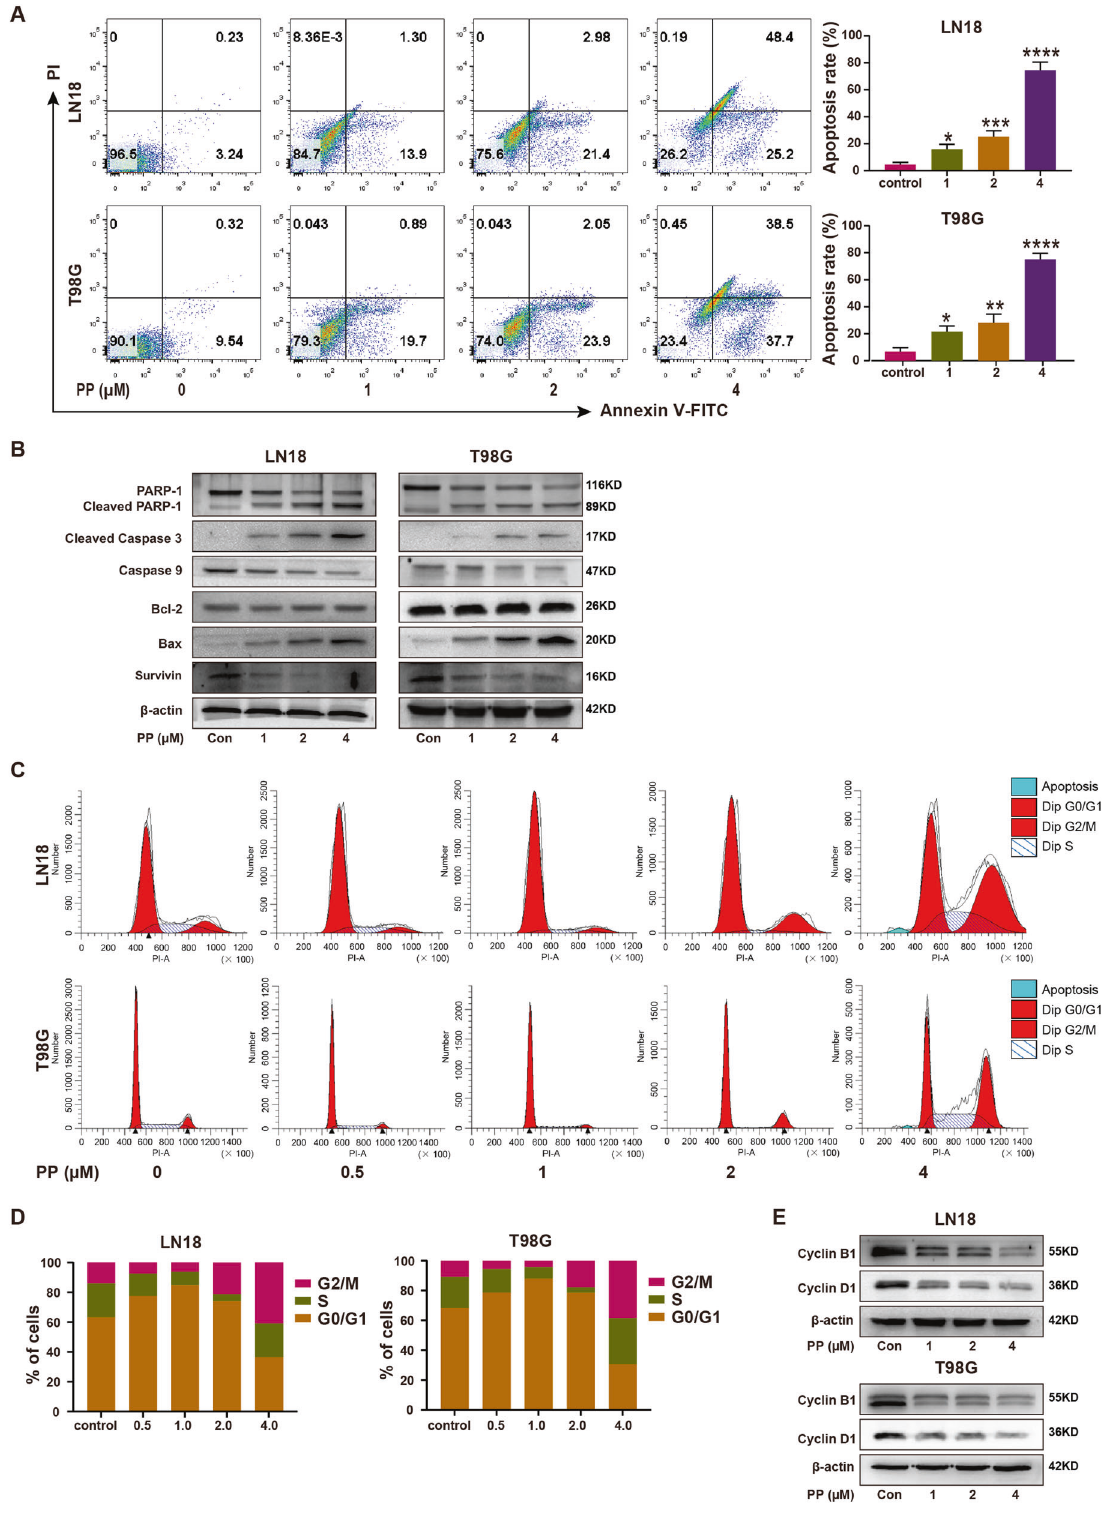
Fig. 2 PP induced GBM cells apoptosis and the arrest of cell cycle. A LN18 and T98G cells were subjected to PP treatment at various concentrations for 48 h, and then fl ow cytometry was carried out along with annexin V-FITC and PI staining (left panel). The elevated apoptotic cells were quanti fi ed and presented in the histogram (right panel) ( n = 3). B The protein levels of PARP-1, Bcl-2, Bax, caspase-9, cleaved caspase-3, and survivin were evaluated through western blotting following PP treatment at different contents. C PI staining combined with fl ow cytometry showed cell cycle distribution in the LN18 and T98G cell lines following PP treatment at different contents. D Histograms showed LN18 and T98G cell percentages at G0/G1, S as well as G2/M phase, respectively. E The cyclin B1 and cyclin D1 protein expression within LN18 and T98G cell lines following PP treatment for 48 h. The results were presented in the manner of mean ± SD. Compared with control group, * p < 0.05; ** p < 0.01; *** p < 0.005; **** p < 0.001. Cell Death Discovery (2021)